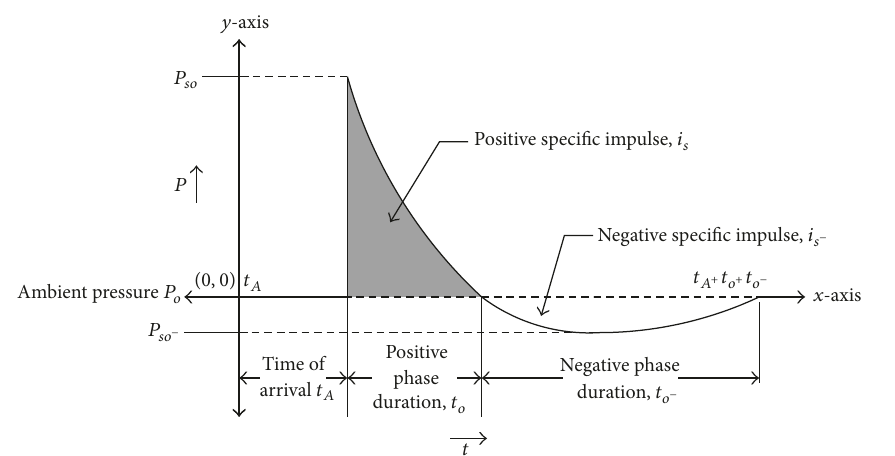
Figure 1: Pressure-time history (reproduced from UFC 3-340-02